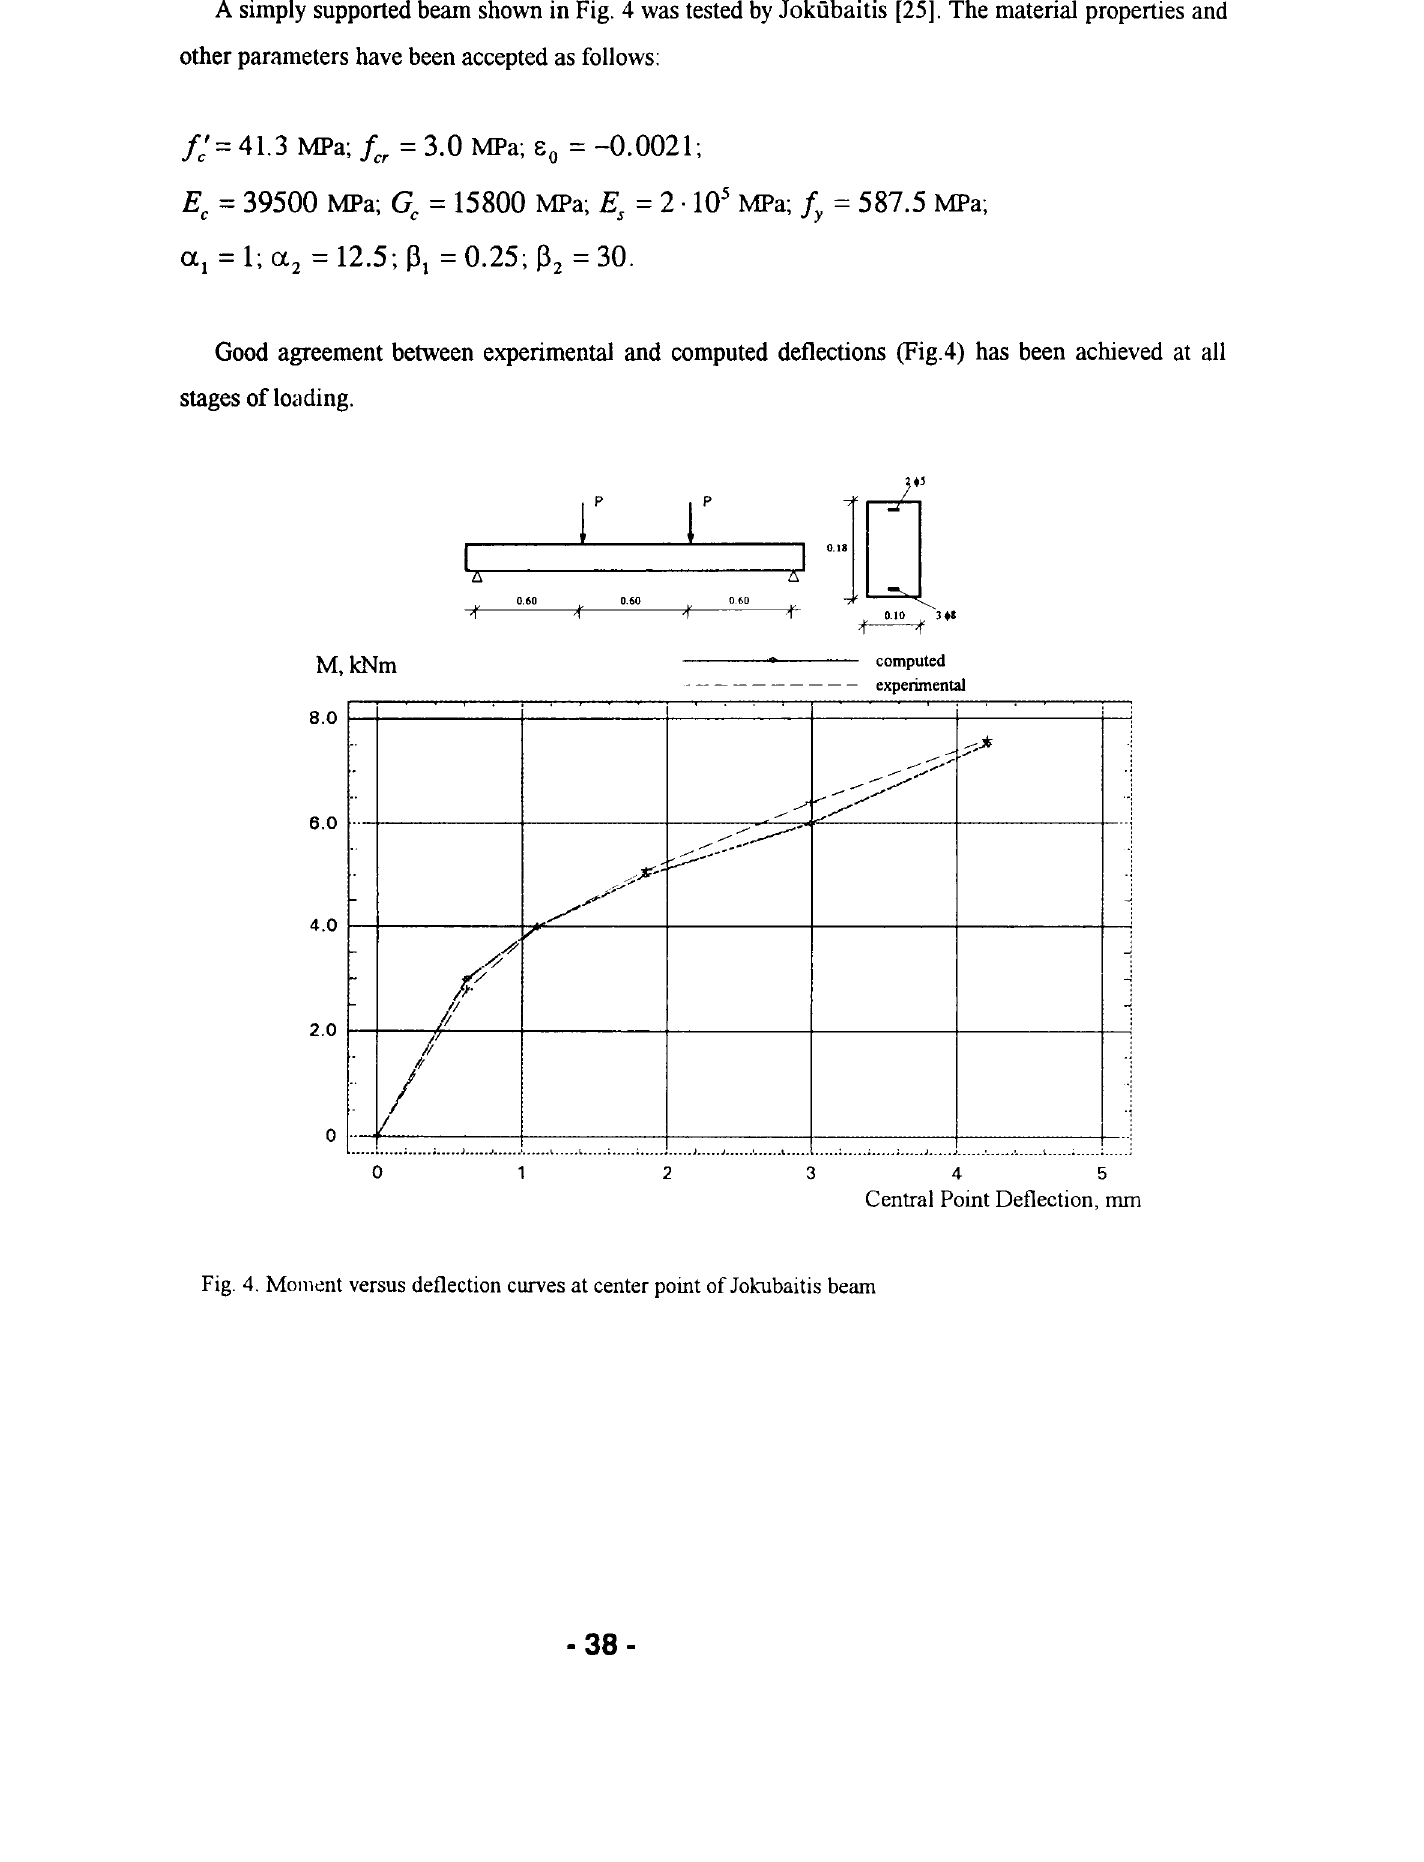
Fig. 4. Momt!nt versus deflection curves at center point of Jokubaitis